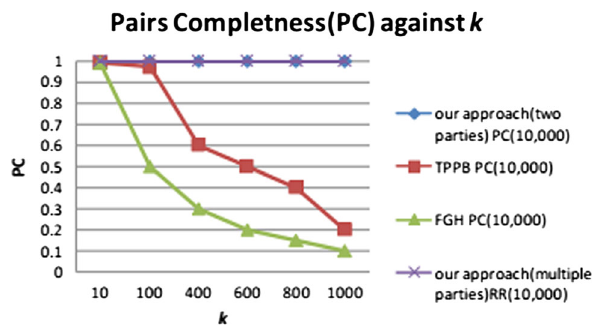
Fig. 6 PC with different values for k , dataset size = 10,000